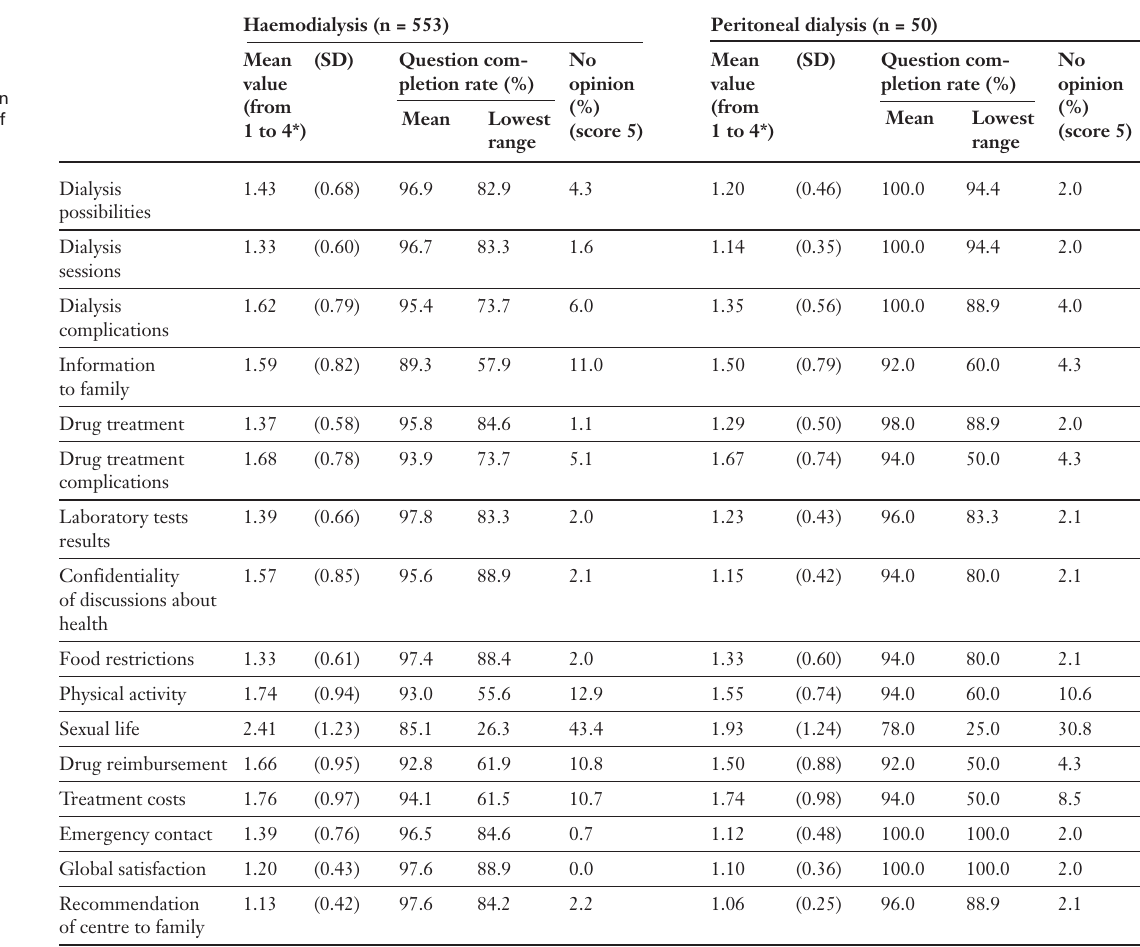
Table 3 Distribution of re- sponses to assess- ment of information received, by type of